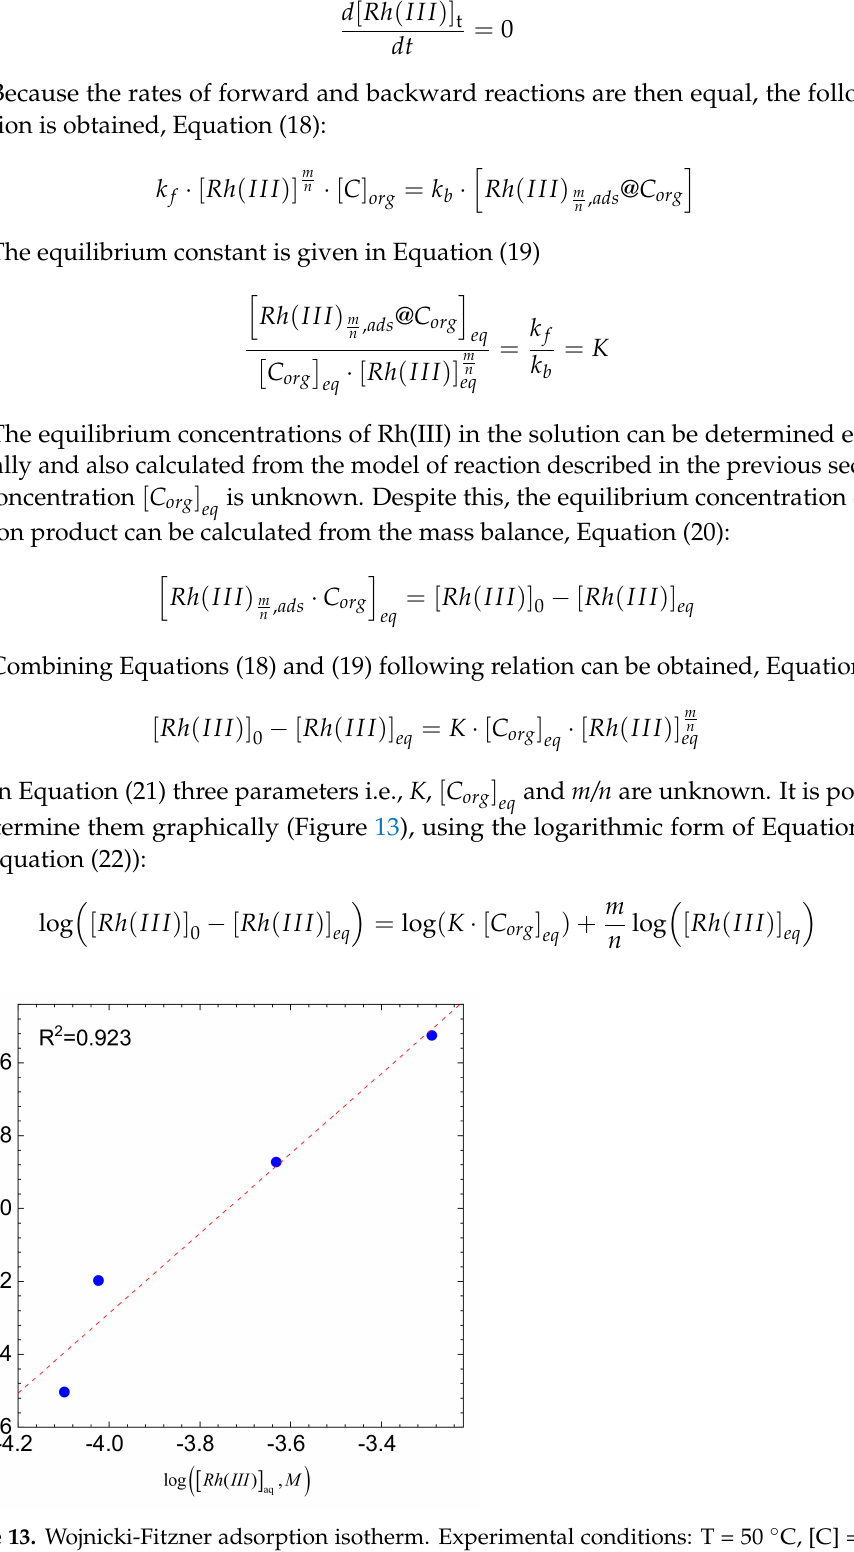
Figure 13. Wojnicki-Fitzner adsorption isotherm. Experimental conditions: T = 50 ◦ C, [C] = 0.5 g, pH = 1, [Br] − = 0.1 M, stirring rate 1200